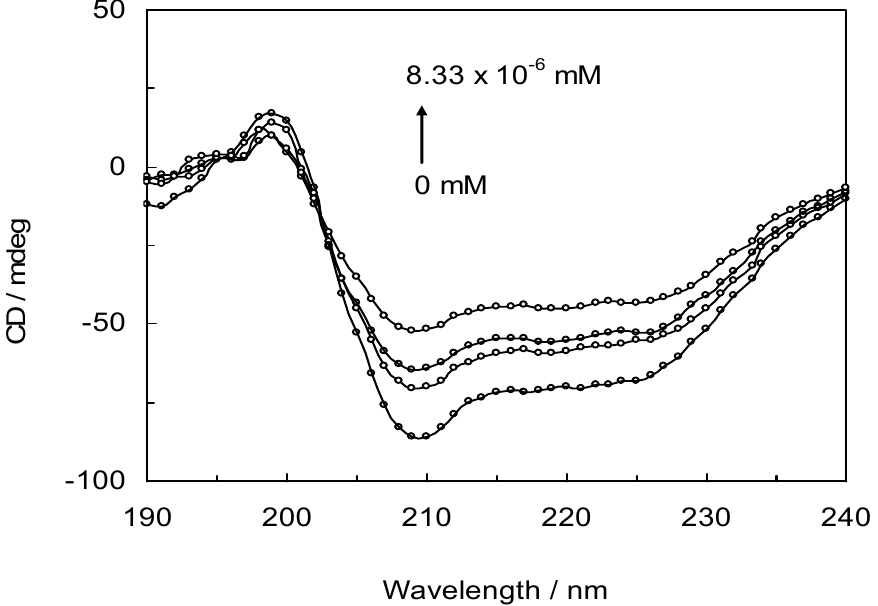
Figure 9. Far-UV CD spectra of LYZ and CYC. pH = 7.4 and T = 298 K. [LYZ] = 1 × 10 − 3 mM, The concentrations of CYC ranged from 0 to 8.33 × 10 − 6 mM.